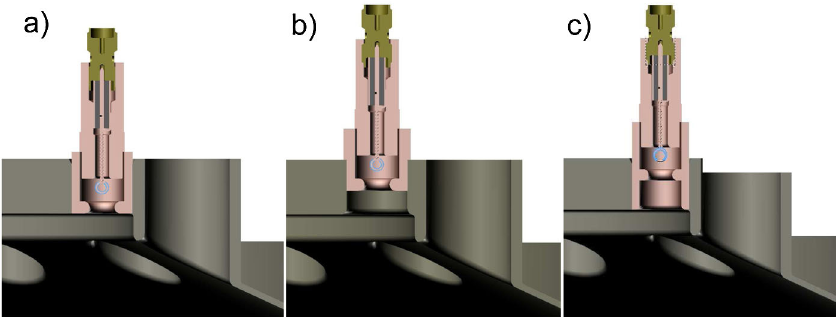
FIG. 4. (Color) Schematic of the (a) original inner-MITL current monitor configuration, (b) the best design, and (c) the experimentally fielded or final design. In each of these schematics, the load is to the left and the upper post of the convolute is to the right of the